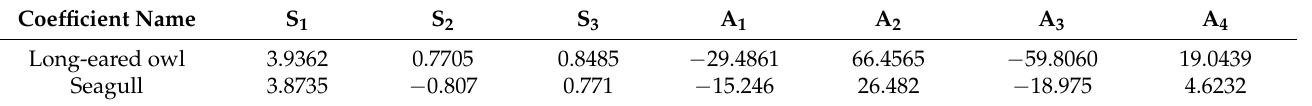
Table 1 lists the values for S n and A n. Table 1. Parameters of long-eared owl and seagull